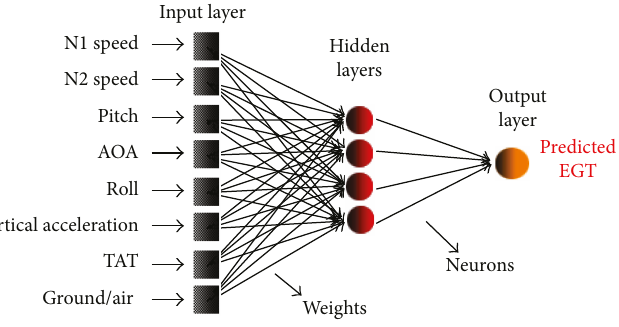
Figure 5: Architecture of the proposed neural model. Table 12: Comparison of the feedforward neural network training algorithms for their test MSE value.